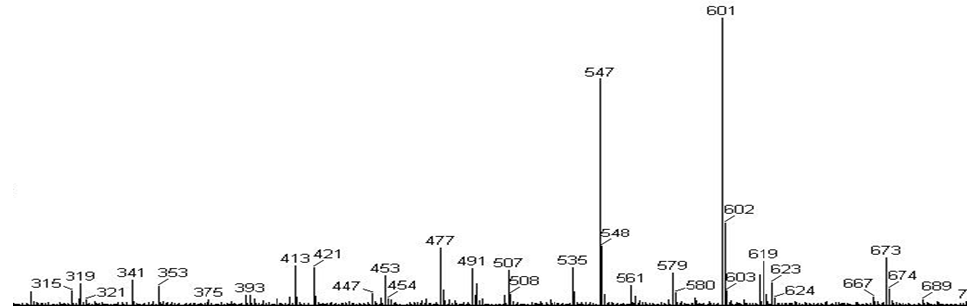
Figure 3. Mass spectrometry of polymers.